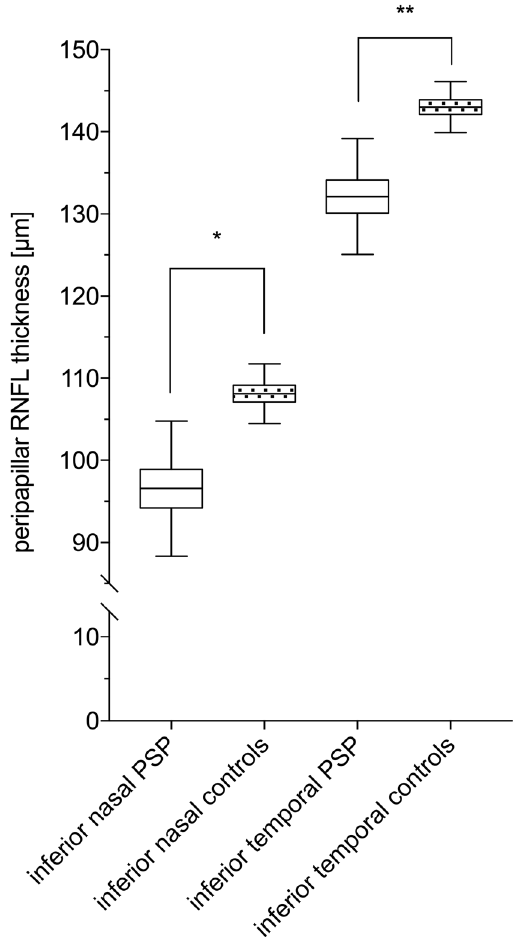
Figure 1. Peripapillary RNFL thickness measured by OCT. Significantly different sectors around the optic nerve head are shown. ns: not significant p > 0.5, * p ≤ 0.5, ** p ≤ 0.01, *** p ≤